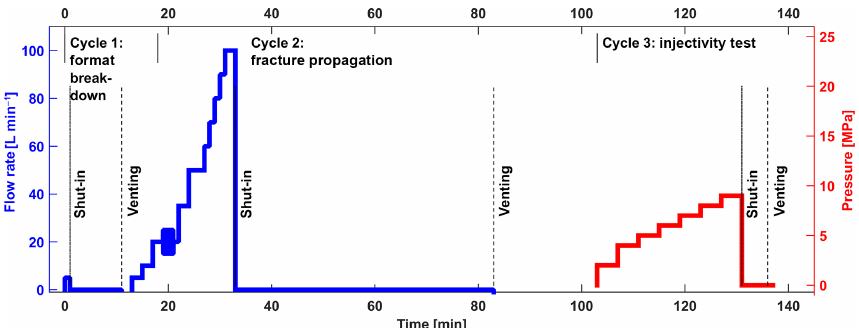
Figure 7. Injection protocol for hydro-fracturing experiments. The blue solid curve denotes flow-rate-controlled injection and the red solid curve pressure-controlled